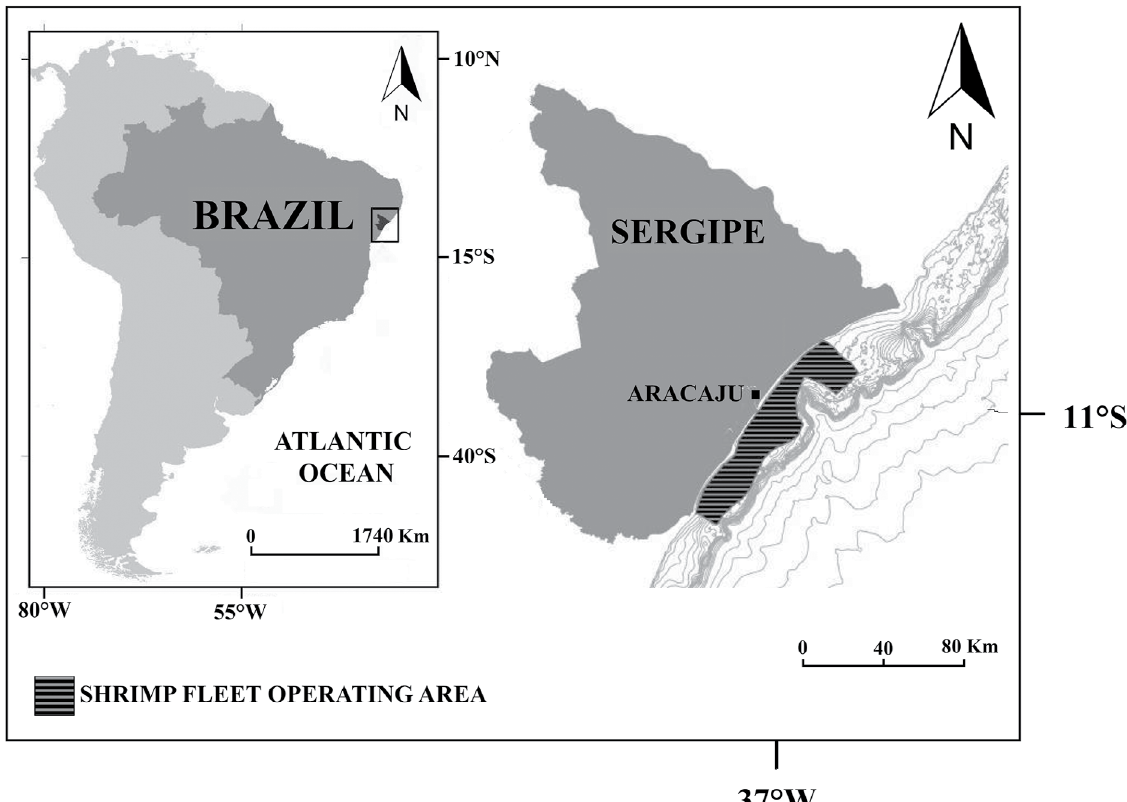
Figure 1. Map showing the approximate location of the Port of Aracaju and the shrimp fishing ground on the coast of